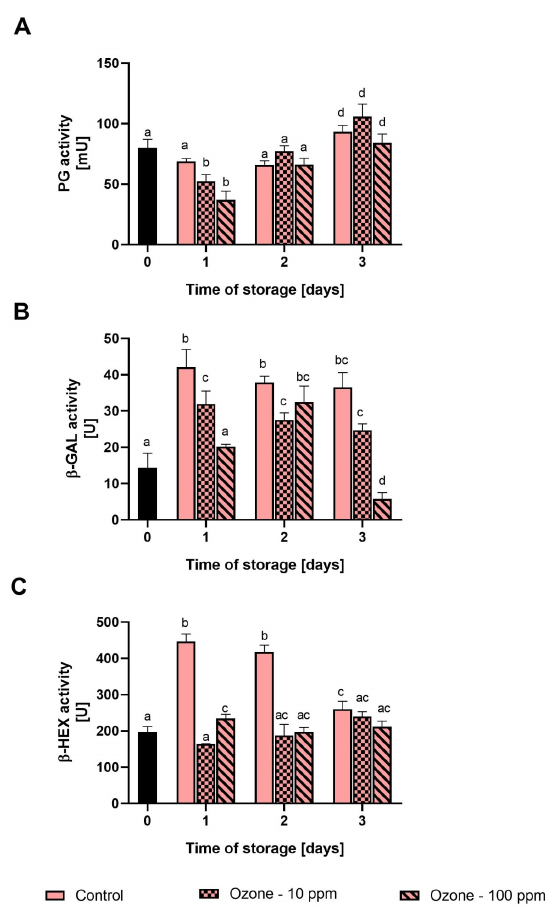
Figure 2. Effect of ozonation process on the activity of polygalacturonase ( A ), β -galactosidase ( B ) and β -hexosaminidase ( C ) in strawberry fruit during storage at room temperature. Mean values with standard deviations (error bars), with the same lower case are not statistically significant according to the t-Tukey test ( α = 0.05).